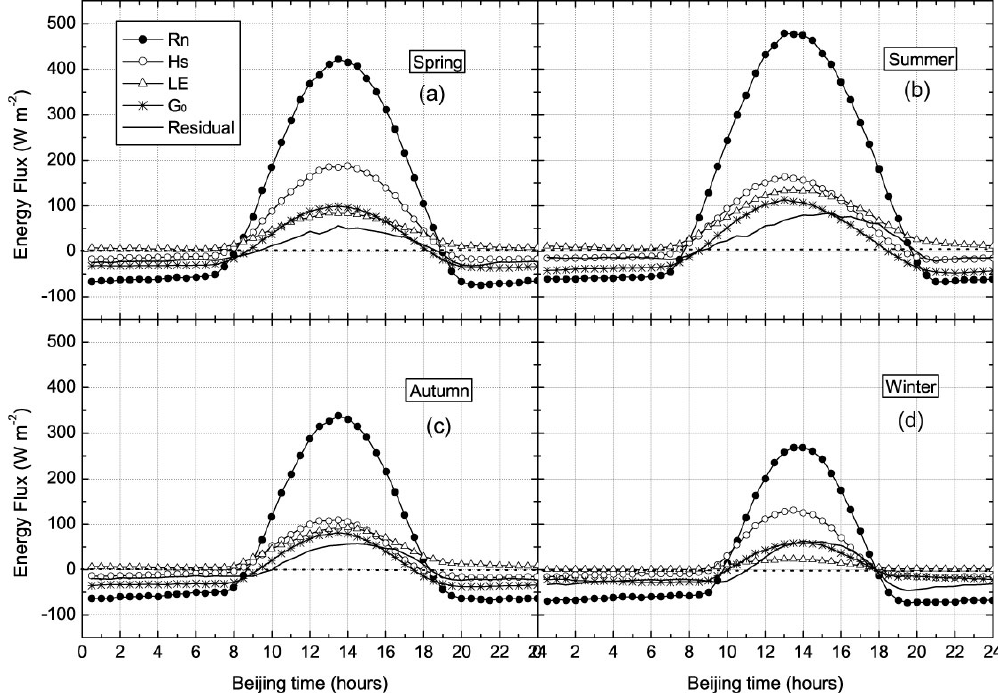
Fig. 4. Seasonally averaged diurnal cycle of the components of energy balance over the native grassland of the semi-arid Loess Plateau in (a) spring, (b) summer, (c) autumn, and (d)